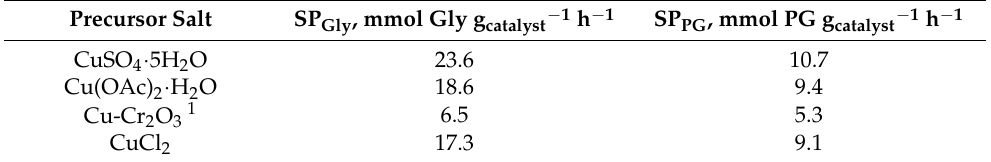
Table 4. The SP values for the various copper catalysts in the glycerol hydrogenolysis. T = 200 ◦ C,